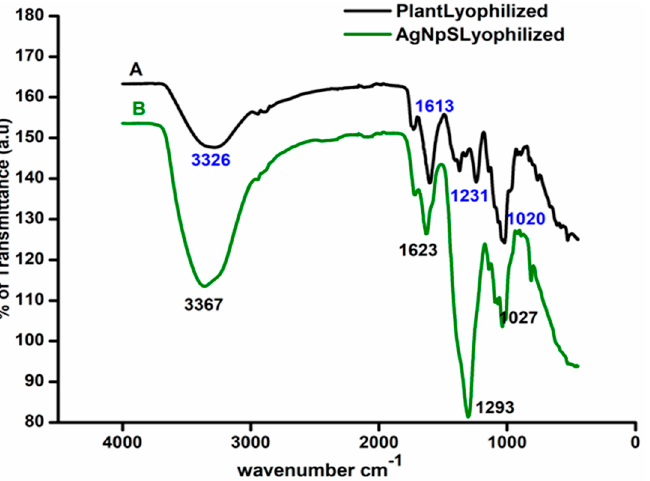
Figure 2. FTIR spectra of ( A ) Lyophilized aqueous M.frondosa leaf extract ( B ) Lyophilized AgNPs.